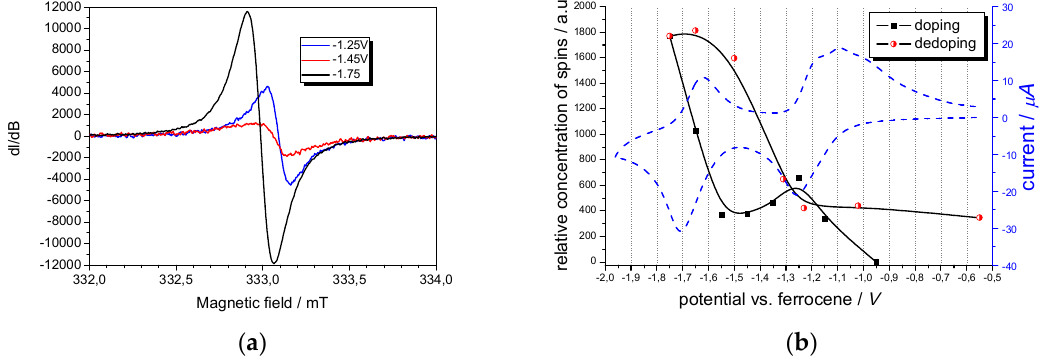
Figure 3. Electron Paramagnetic Resonance spectroelectrochemistry: ( a ) first derivative of selected EPR signals in restricted range; ( b ) relative concentration of spins at different potential.